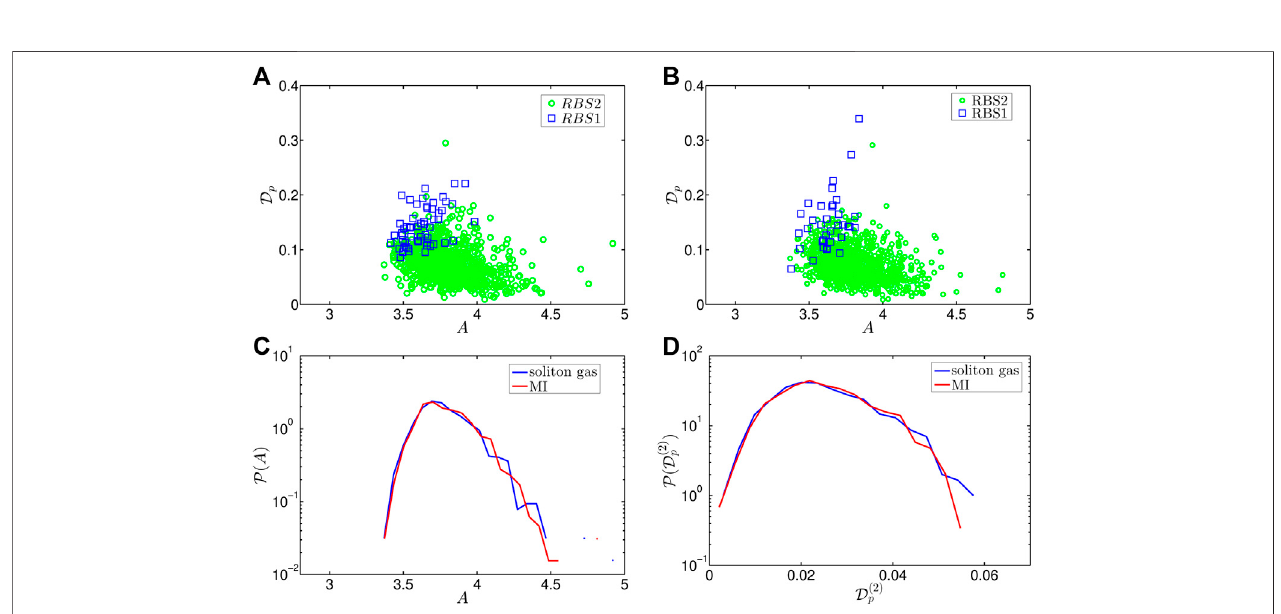
FIGURE2| ( Coloron-line ) (A,B) Deviation D p (cid:2) min { D ( 1 ) p , D ( 2 ) p } betweenRWsand theirbest fi tswitheithertheRBS1ortheRBS2vs.themaximum amplitude A of the RW: (A) for thesoliton gasand (B) for theMI ofthe condensate close toits statistically stationary state. The blue squares indicate that thebest fi tisachievedwith the RBS1and thegreencircles – withtheRBS2. (C,D) ThePDFs of (C) themaximumamplitude A foralltheRWsand (D) thedeviation D ( 2 ) p fortheRWsbetterapproximated with the RBS2, for the soliton gas (blue) and the MI of the condensate close to its statistically stationary state (red).